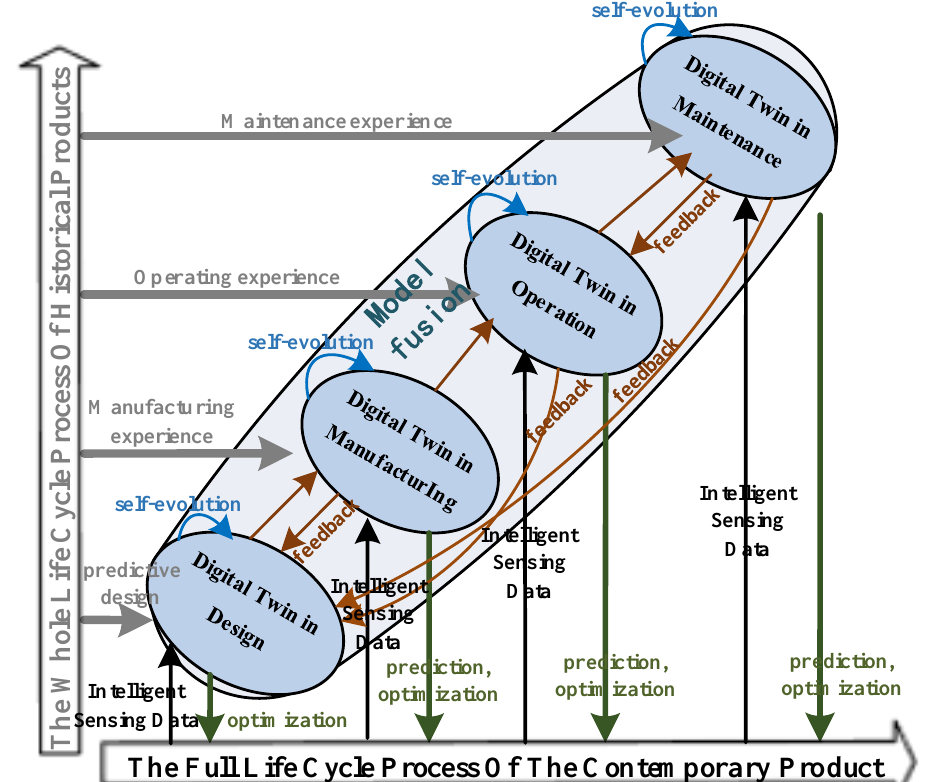
Figure 1. The V-H for PWLC digital twin.